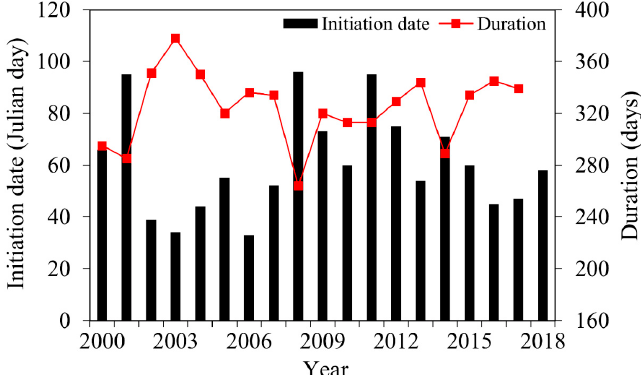
Figure 5. Initiation date and duration changes of algal blooms in Lake Dianchi from 2000 to 2018.